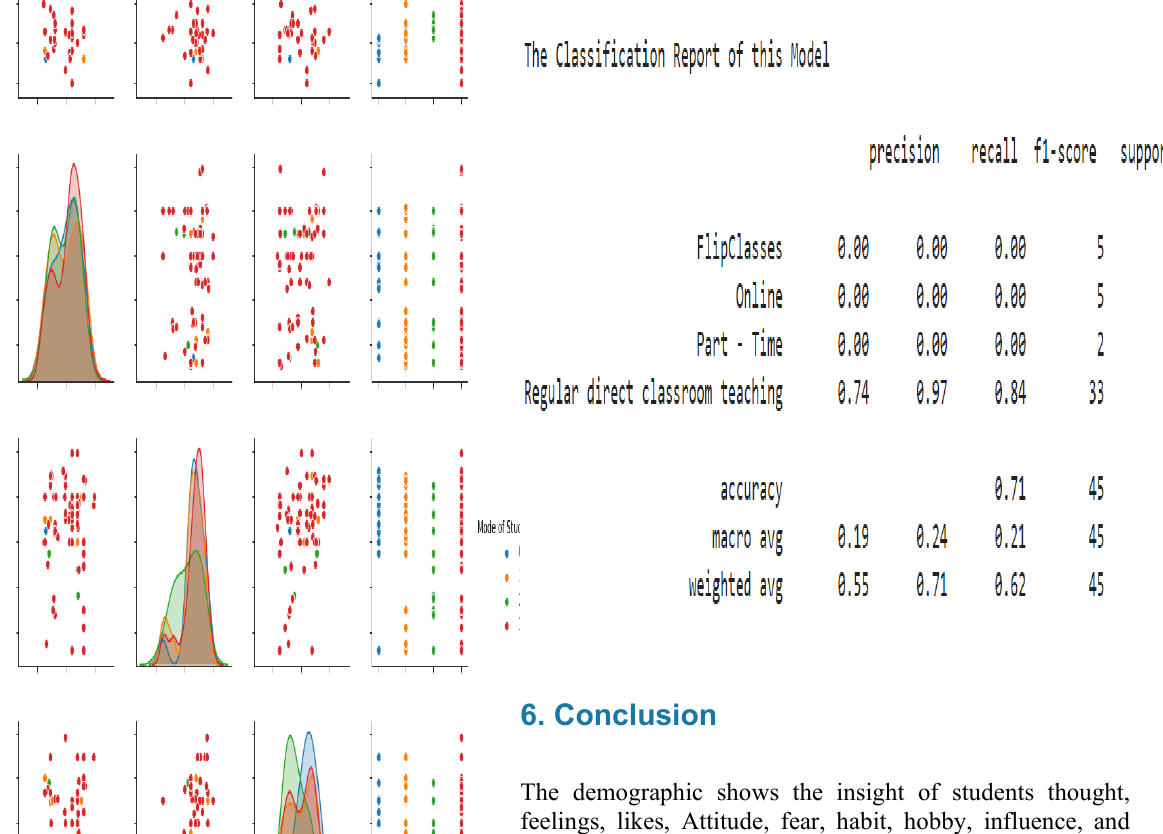
Table 2. Classification report of the